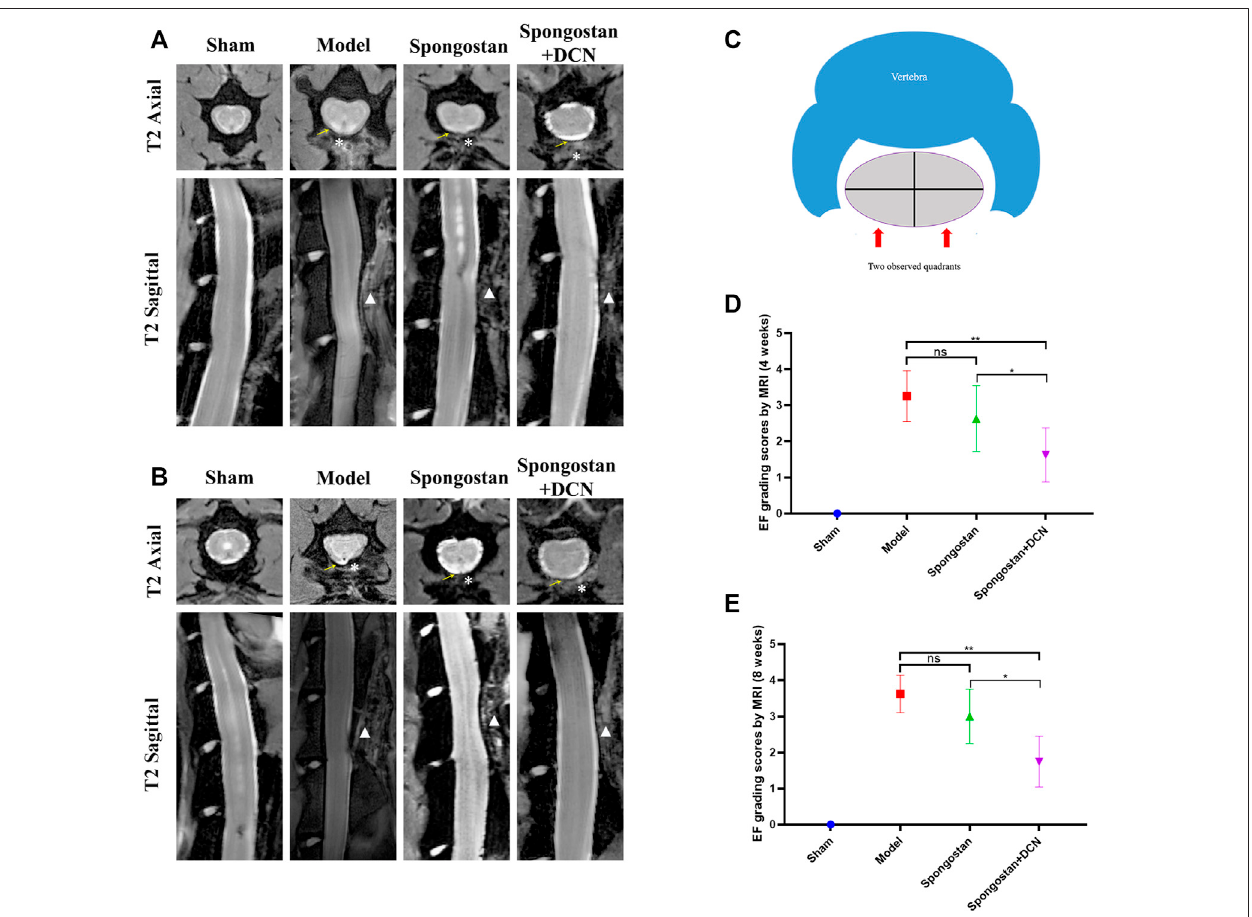
FIGURE 7 | Results of MRI evaluation. The axial and sagittal T2-weighted MRIs of laminectomy sites at (A) 4 weeks and (B) 8 weeks. Yellow arrows indicate the dura mater. * indicates the epidural dense scar tissues. White triangles in sagittal images indicate lamina defect site. (C) Schematic diagram of the axial image used for epidural fi brosis (EF) scoring. (D) Four weeks and (E) 8 weeks EF score results based on MRIs. ns indicates no signi fi cance. * p < 0.05; ** p < 0.01.